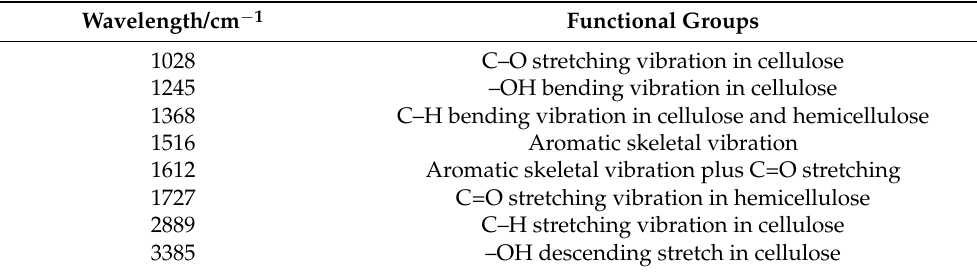
Table 4. Functional groups of FTIR of different fiber components.